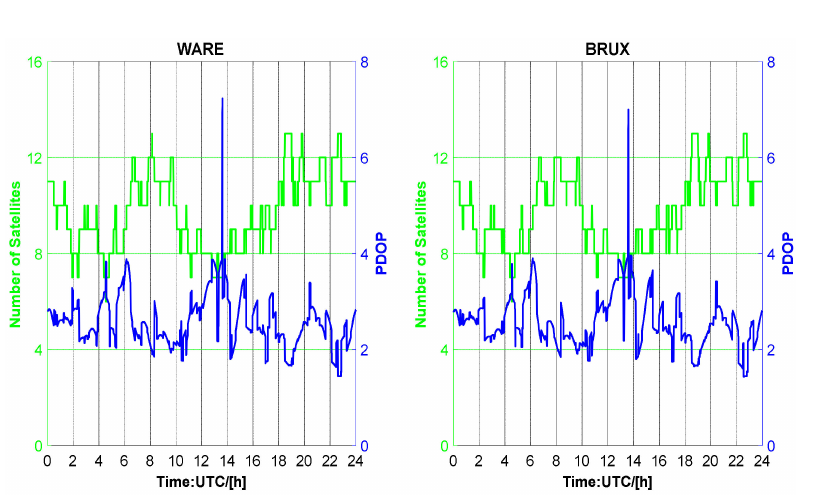
Figure 4. Number of satellites and PDOP from WARE and BRUX station on DOY 082,